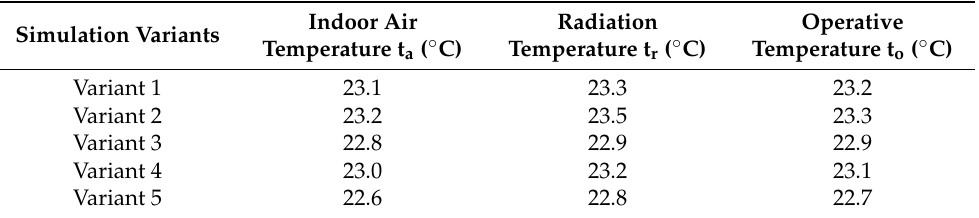
Table 5. Mean values of indoor air, radiation, and operative temperatures for the monthly analysis period of the five adopted variants of the